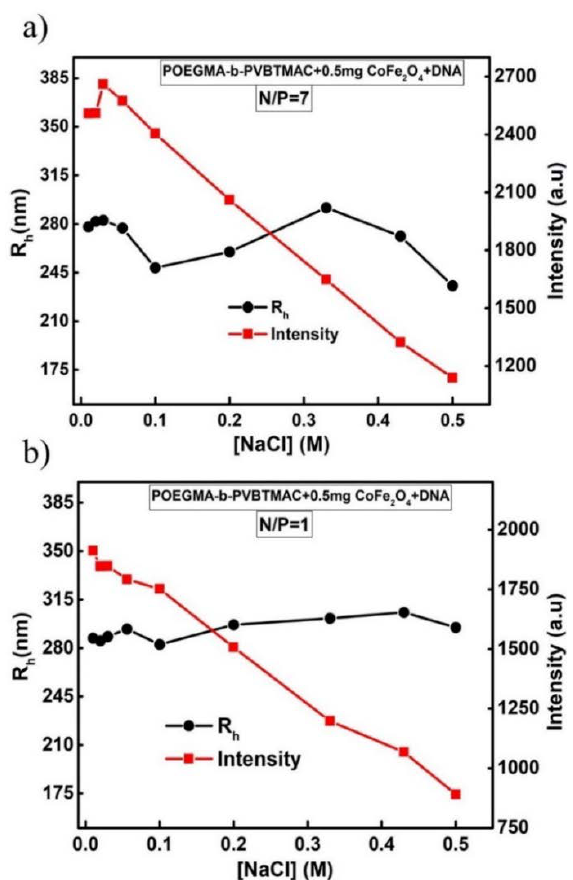
Figure 7. R h and scattered intensity as a function of ionic strength ([NaCl]) for magnetopolyplexes at ( a ) N / P = 7 and ( b ) N / P = 1.